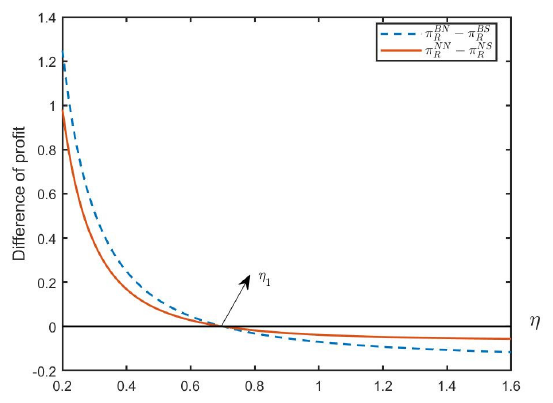
Figure 7. The impact of η on profit difference. ( α = 2.2, ε = 0.2, η = 0.9, σ = 0.68).